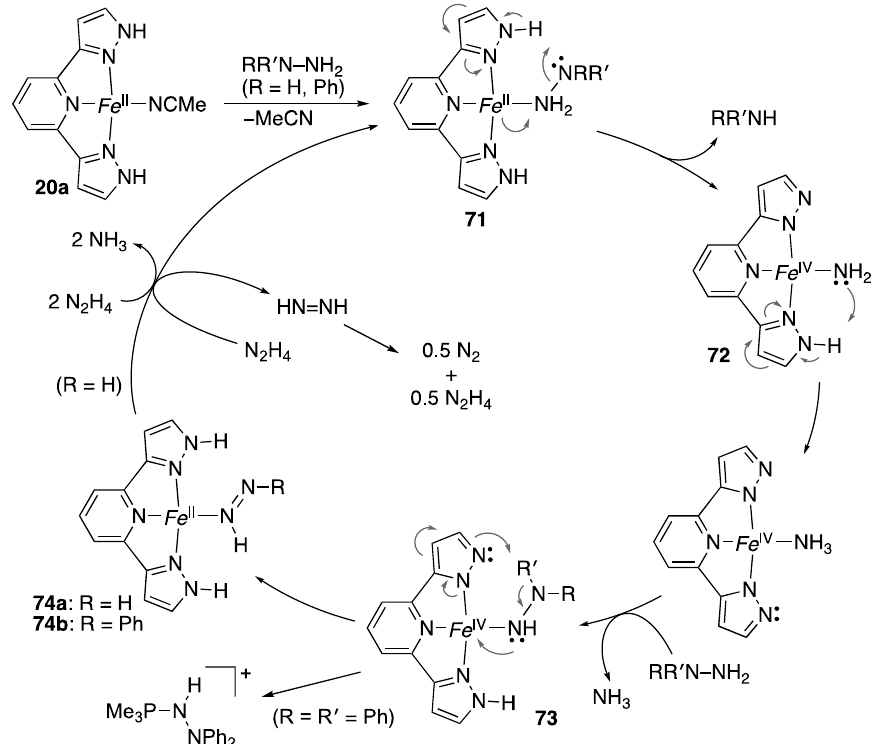
Scheme 21. Proposed mechanism for catalytic disproportionation of hydrazine with a protic pincer- type iron complex. Fe = Fe(PMe 3 ) 22+ . The total charge of the iron complexes (+2) and tert -butyl groups in the pincer ligand are omi tt ed.